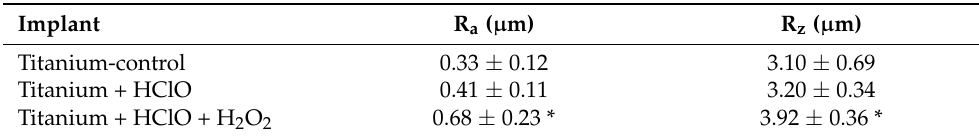
Table 1. Roughness for each dental implant studied. * Means differences statistically significant with p < 0.01.